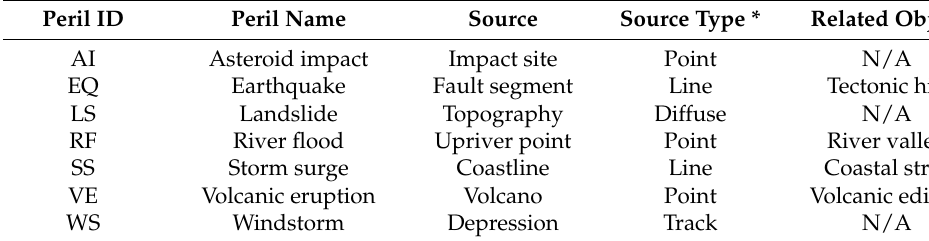
Table 1. Peril source and related environmental object.